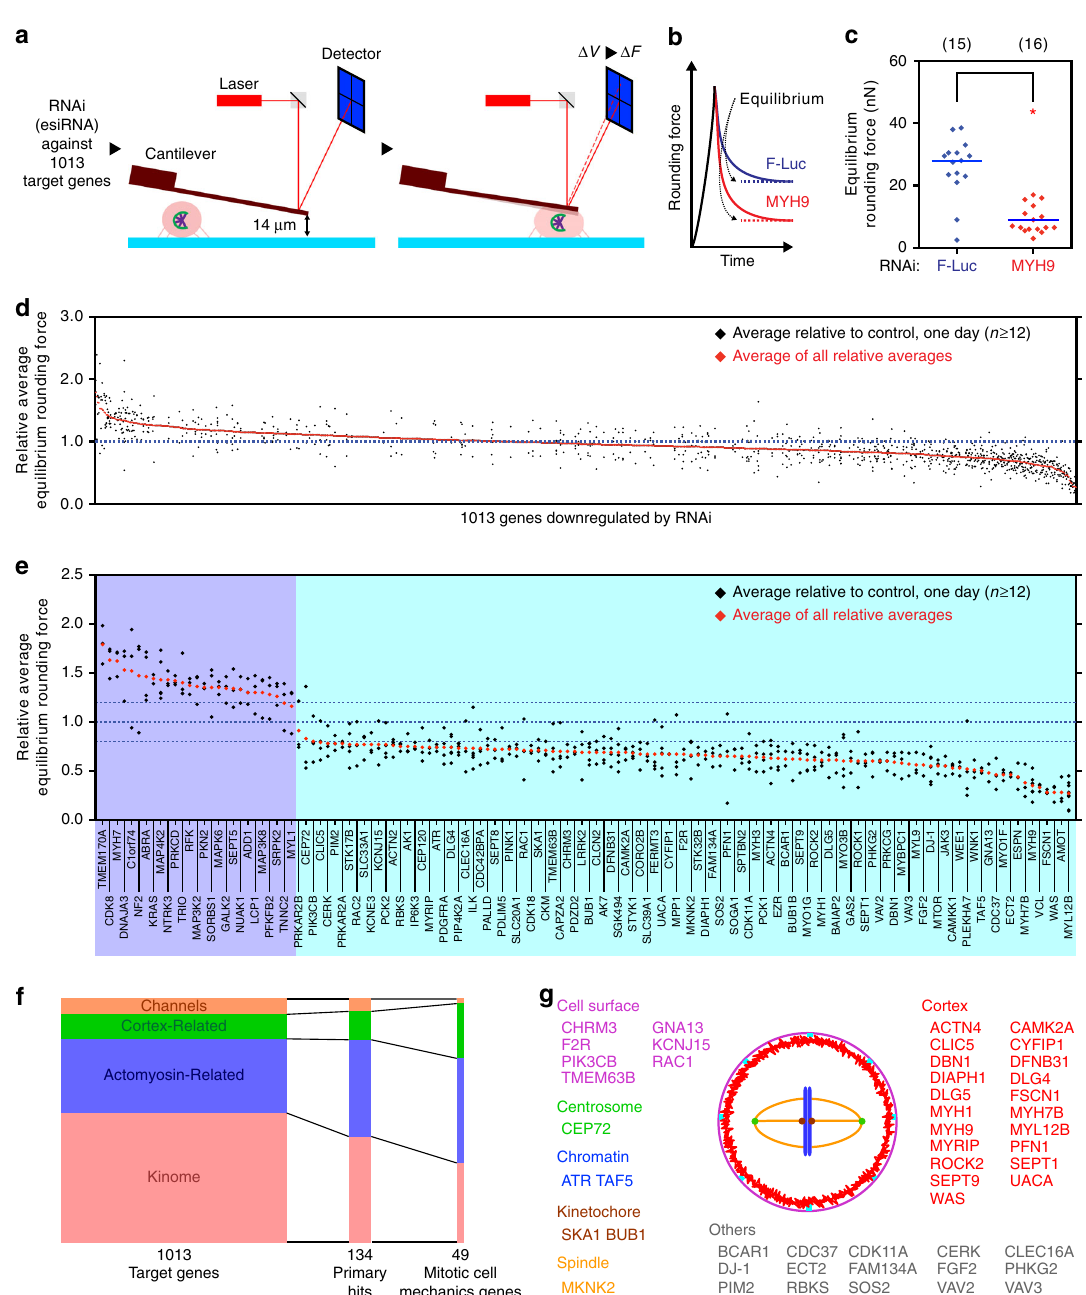
averages0.01.02.03.0 Average relative to control, one day ( n ≥ 12) Average of all relative averages Average relative to control, one day ( n ≥ 12) Average of all relative Fig. 1 RNAi-based screen to identify genes affecting mechanical properties of mitotic cells. a Procedure for screening mechanical properties of mitotic cells. Cells were RNAi-transfected 48 – 72h before experiments and chemically arrested in mitosis. A tipless microcantilever was used to con fi ne ~20 µ m high mitotic cells at 14 µ m and to measure the response force ( “ rounding force ” , Δ F in the schematic). Δ V , photodiode voltage measuring the force-induced cantilever de fl ection via a laser (red). b Typical time-dependent rounding force of con fi ned mitotic cells. Traces for control ( fi re fl y luciferase, F-Luc, blue) and myosin II (MYH9, red) RNAi. Equilibrium rounding forces are achieved within 10 – 30s (dashed lines). c Plot of equilibrium rounding forces of mitotic cells treated with F-Luc and MYH9 RNAi. Each diamond indicates rounding force of a mitotic cell. ‘ ( n ) ’ , number of cells measured. Blue bars, mean. Statistical signi fi cance was determined by Student ’ s t -test (* p ≤ 0.05). d Overview of the primary screen results. The relative average equilibrium rounding force of RNAi-treated cells vs. F-Luc control RNAi-treated cells is plotted. At least 12 cells were analyzed per condition. The genes ( x axis) are ordered by the average relative force (red). Blue dotted line denotes average relative equilibrium rounding force for control cells. See Supplementary Fig. 2 for screen work fl ow and Supplementary Data for full results. e Primary hit genes (134/1013) with relative equilibrium rounding forces. At least 12 cells were analyzed per condition. Blue dotted lines denote average (thick line), 80 and 120% of average (thin lines) for control cells. Dark blue and light blue backgrounds denote hits repeatedly leading to statistically signi fi cant increased and decreased relative equilibrium rounding forces, respectively. f Portion of genes belonging to the indicated gene class in the initial set of target genes, primary hits and mitotic cell mechanics genes. Relative size of rectangles represents the number of genes. g Subcellular localization of the 49 mitotic cell mechanics genes according to the literature 24, 25 . Red barbed line, cell cortex; magenta, cell surface; pale blue, plasma membrane-cortex linker; green, centrosome; blue, chromatin; brown, kinetochore; orange, mitotic spindle; ‘ others ’ include cytoplasm, mitochondria, endoplasmic reticulum, and